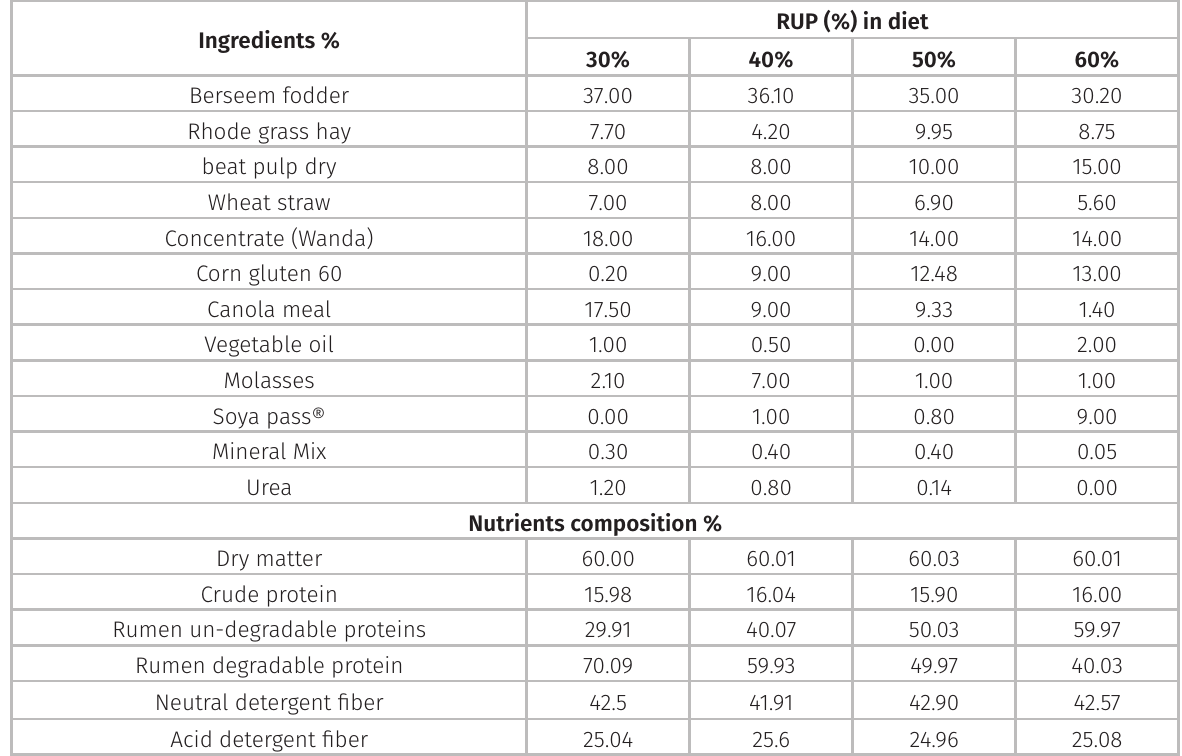
Table I. Ingredient and nutrient composition of the diets. Ingredients